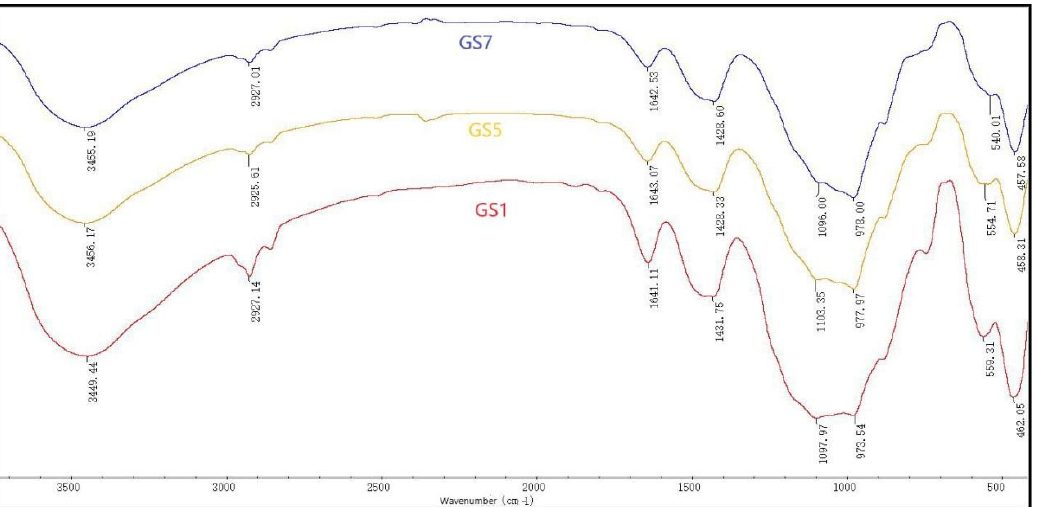
Figure 22. GS paste FT-IR image. Table 5. FTIR absorbance peaks for GA specimens.